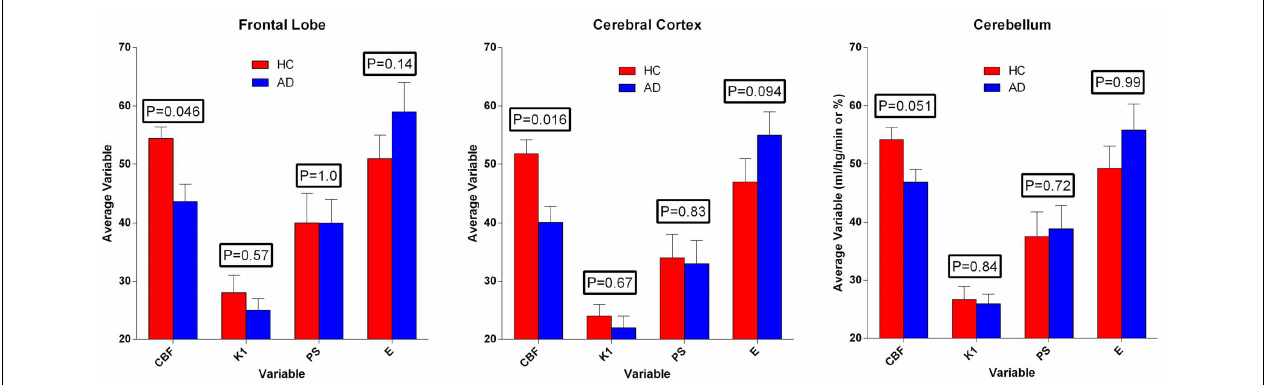
FIGURE 6 | Average estimates ( ± SEM) of cerebral blood flow and (7) and (8). Values of CBF exceeded values of PS-products, which in turn unidirectional clearance, and the calculated values of extraction fraction varied among regions, but did not differ significantly between the two groups. and permeability-surface area product of [ 11 C ] PiB, according to Equations Table 1 | Average estimates ( ± SEM) of unidirectional blood-brain clearance ( K 1 ), extraction percentage ( E ), and permeability-surface area product ( PS ) in regions of brain of healthy control subjects (HC) and patients with Alzheimer’s disease (AD). Variable